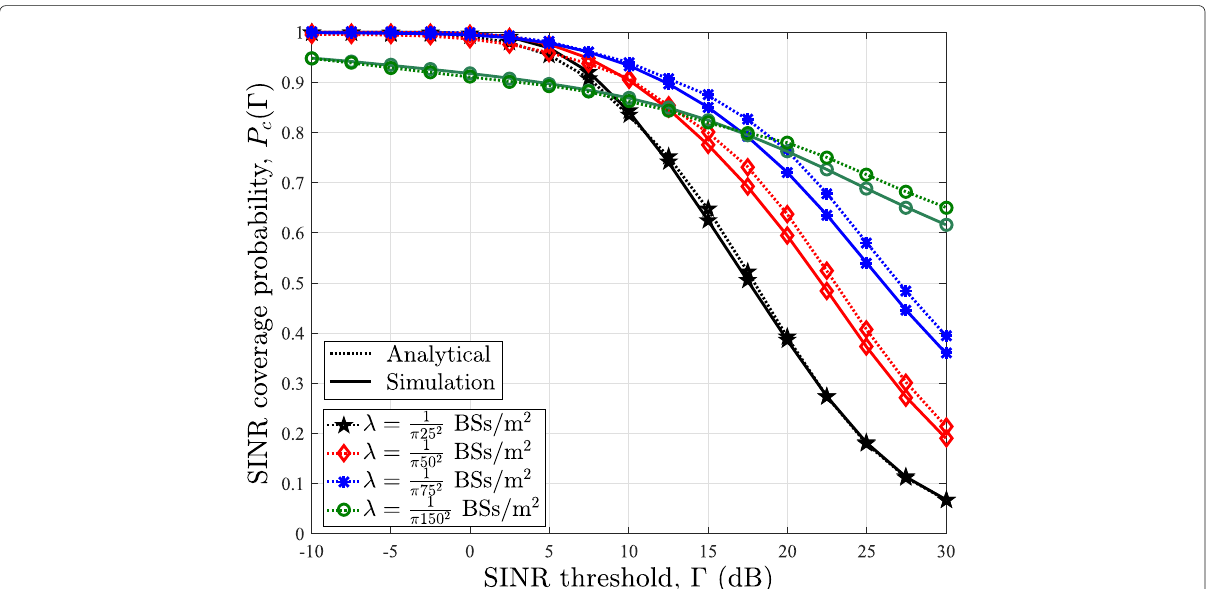
Fig. 6 SINR coverage probability in the uplink of mmWave cellular